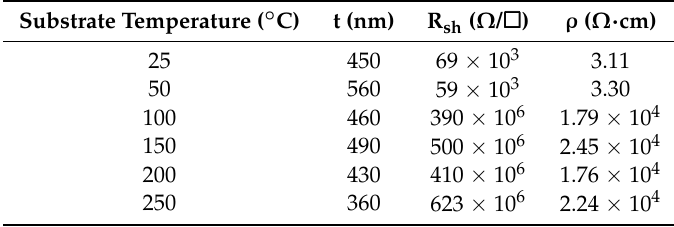
Figure 3. Optical transmittance spectra of CdS thin films deposited at different substrate temperatures. Table 2. Electrical parameters of CdS thin films. t: film thickness; R sh : sheet resistance; ρ :